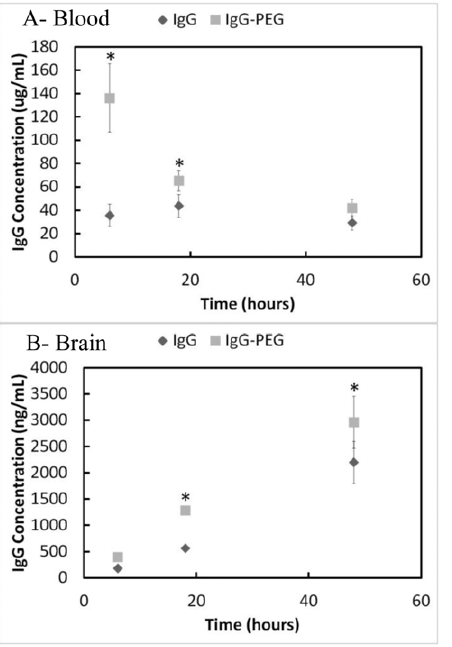
Figure 5. PEG-modification of rabbit IgG results in higher accumulation in brain tissue. (A) PEG-modification of IgG leads to elevated concentrations in the blood at early time points, but is diminished by 48 h. Holm-Sidak post-hoc test after a two-factor ANOVA (antibody and time) revealed significant differences at 6 h (p , 0.001) and 18 h (p=0.027). (B) In contrast, the penetration of IgG into the brain is elevated at the intermediate time points, but by 48 h the effects of PEG-modification begin to diminish in the brain. Holm-Sidak post- hoc test after a two-factor ANOVA (antibody and time) revealed significant differences at 18 h (p , 0.001 and 48 h (p , 0.001) (n=4, mean 6 standard deviation plotted).